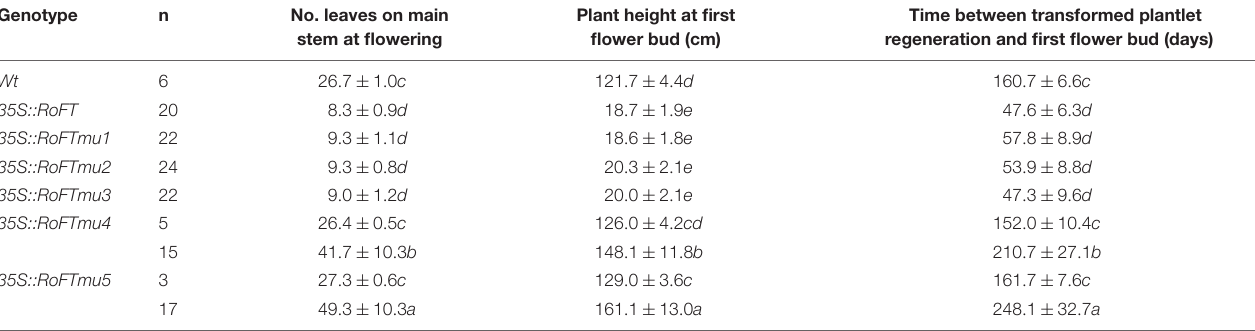
TABLE 2 | Flowering phenotypes of regenerated T 0 transgenic tobacco lines harboring mutated RoFT transcripts. Genotype n No. leaves on main Plant height at first Time between transformed plantlet stem at flowering flower bud (cm) regeneration and first flower bud (days)